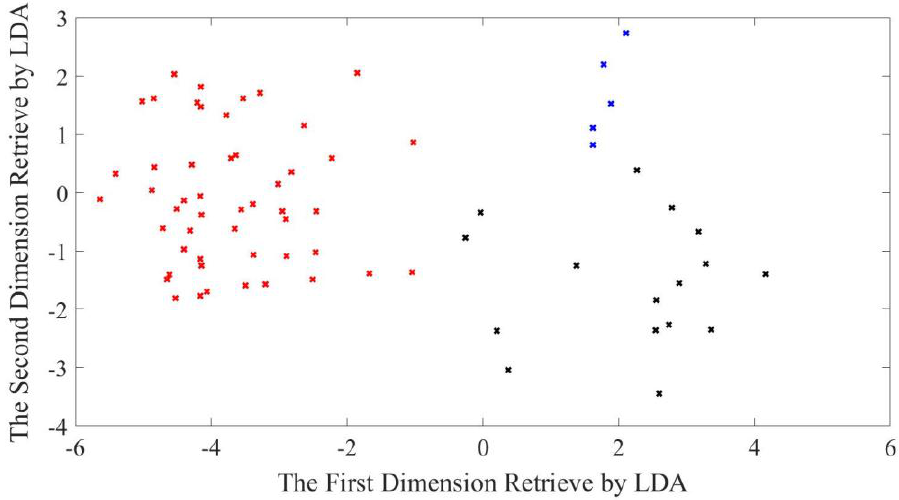
Figure 4. Example of dimensionality